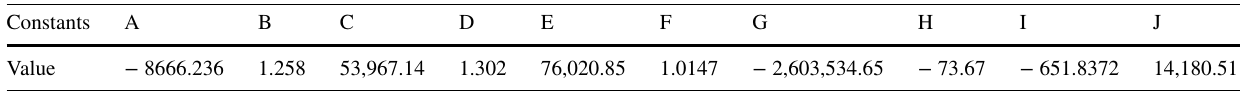
Table 13 The constants determined with n =